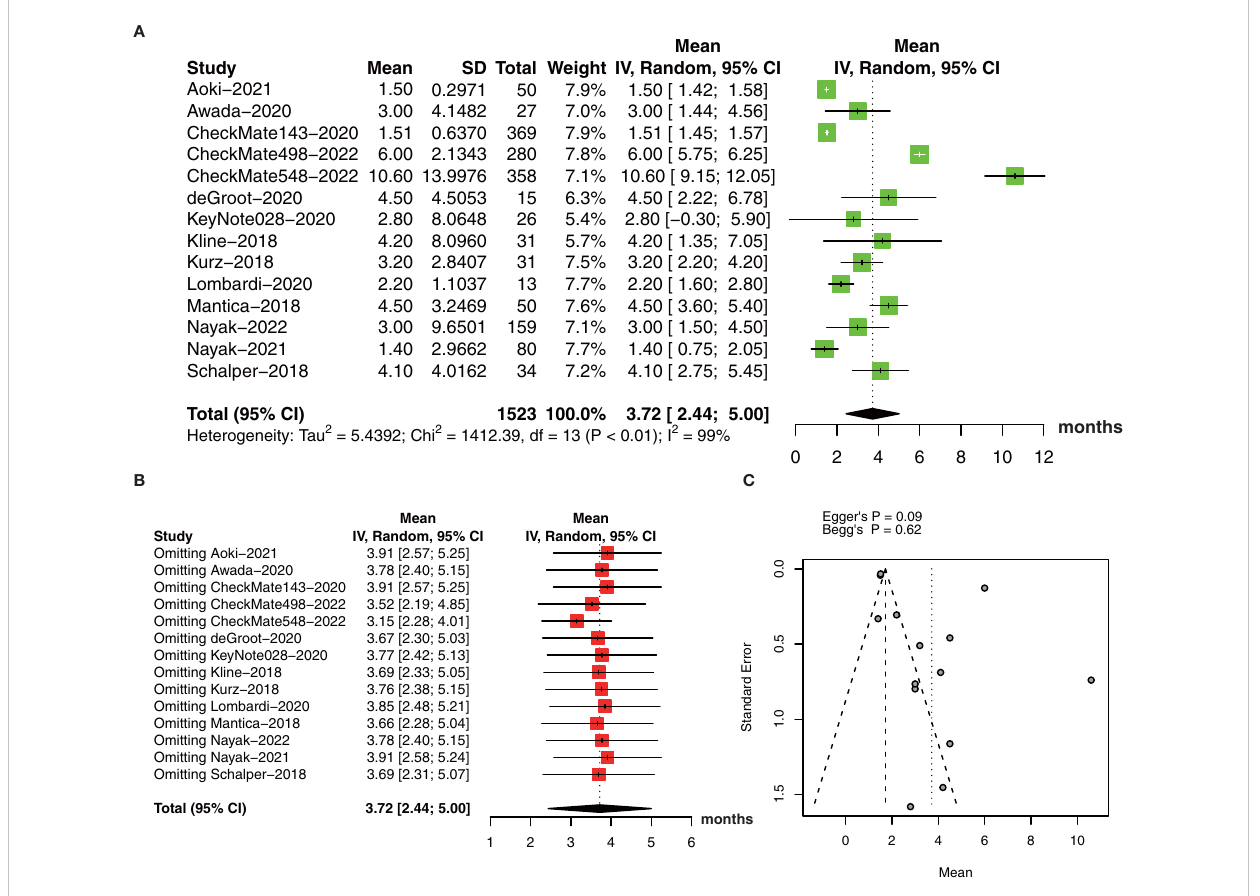
FIGURE 6 (A) The pooled estimate of median PFS. (B) sensitive analysis. (C) funnel plot. PFS, progression-free survival.